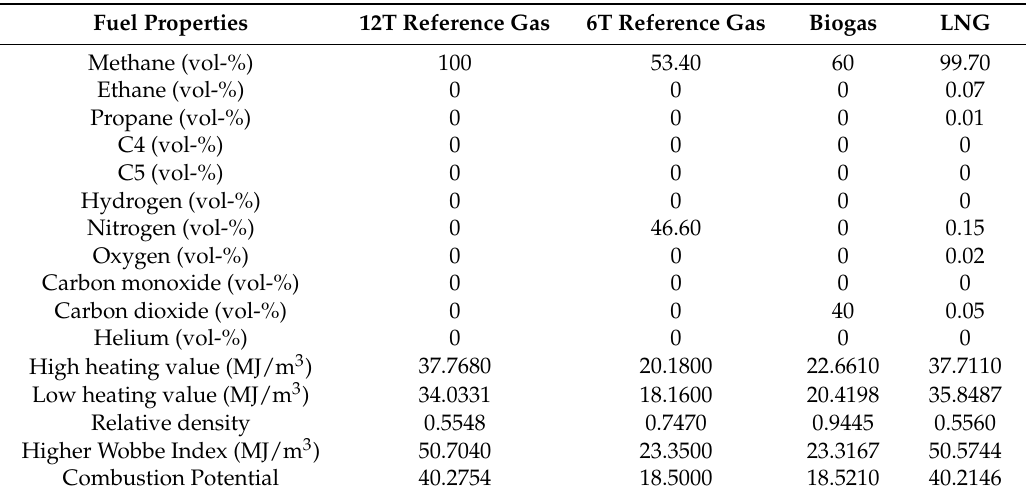
Table 1. Comparison of compositions and characteristics of various gases. Concentrations recalculated to conditions: 293.15 K, 101.325 kPa, and dry